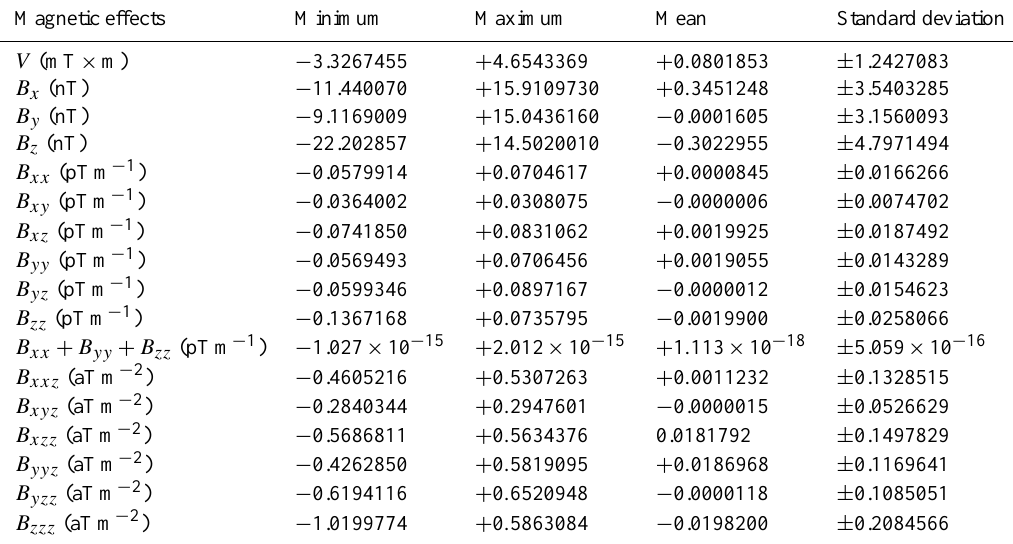
Table 2. Statistics of the magnetic potential, MV, MGT and third-order partial derivatives of the magnetic potential field around the South Pole (150 ◦ ≤ θ ≤ 180 ◦ ) at the altitude of 300km using the lithospheric magnetic field model GRIMM_L120 (version 0.0) (Lesur et al., 2013) for spherical harmonic degrees